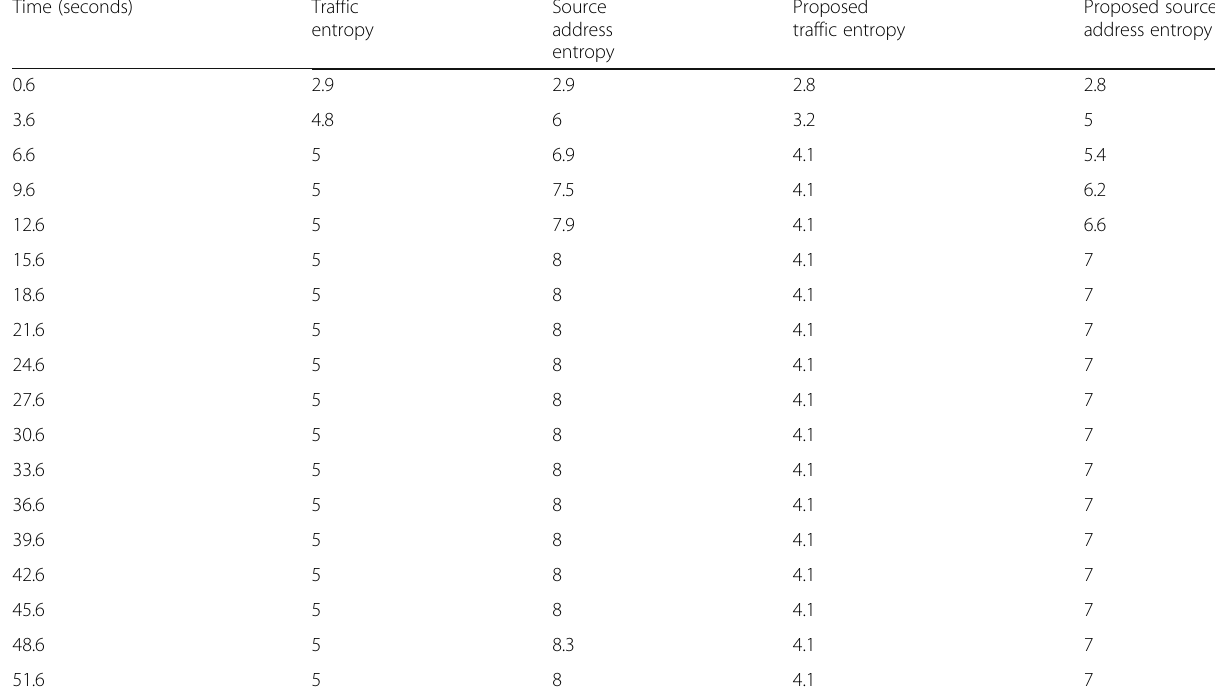
Table 4 Variation in entropy during normal web traffic. At different times, the source address and traffic entropy are provided for both existing and proposed approaches